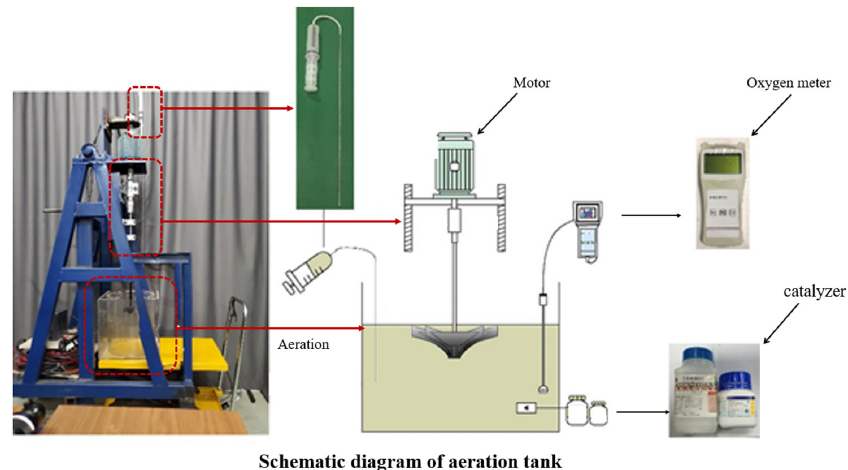
Figure 3. Schematic diagrams of the aeration tank and impeller. In the internal flow test, the drying method is used to measure the sludge concentration distribution in the aeration tank. The layout of the internal flow velocity measuring points is shown in Figure 4.